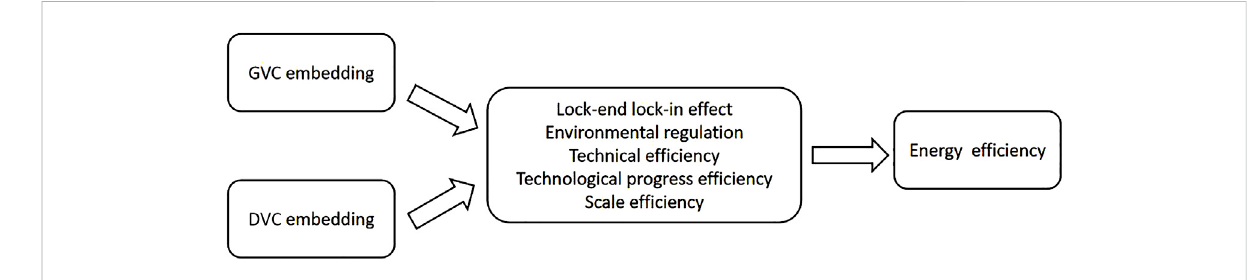
FIGURE 1 Impact mechanisms of GVC/DVC embedding on energy ef fi